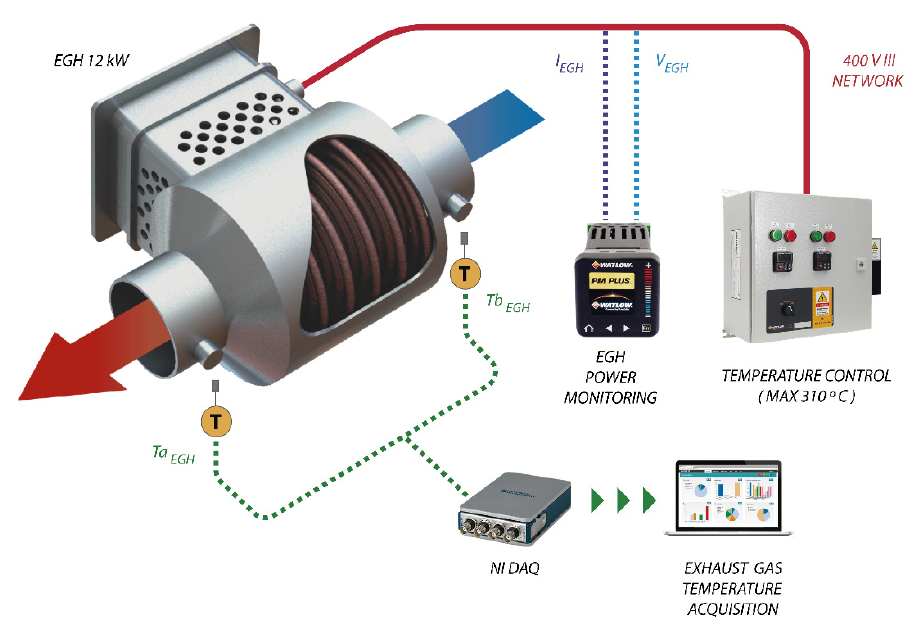
Figure 2. Scheme of the EGH installed upstream the ATS and its data acquisition.